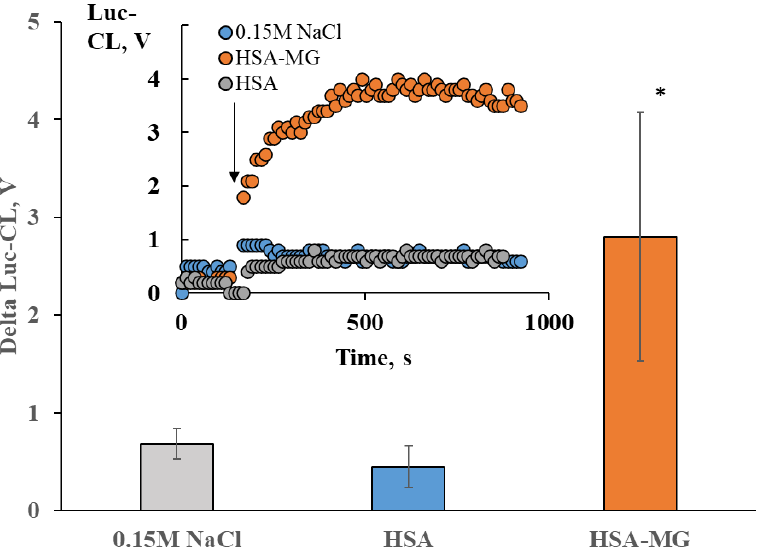
not with HSA (Figure 3).